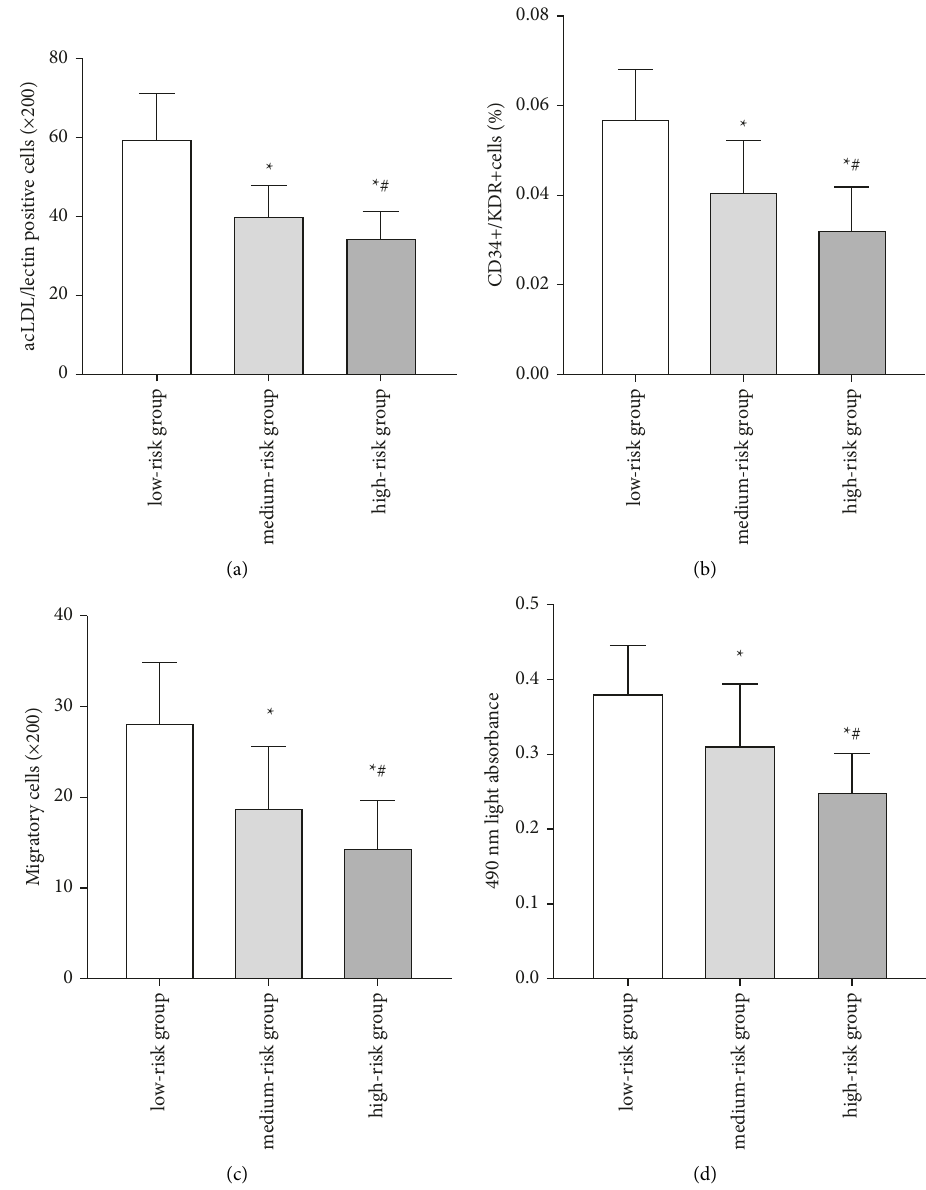
Figure 2: The number and function of circulating EPCs between three subgroups. As the Gensini score increased, the number of circulating EPCs was decreased (a), (b) and the migration and proliferation of circulating EPCs were also declined. (c), (d) Statistical significance was evaluated using Student’s t -test or analysis of